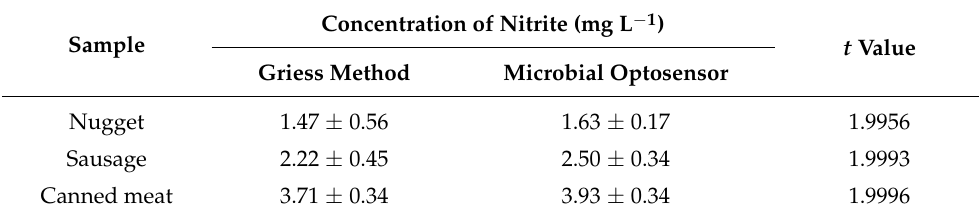
Table 2. Concentration of nitrite determined by both the UV-vis spectrophotometric Griess method and the reflectance microbial optosensor in processed meat products. The calculated t value is compared with the critical t value at 4 degrees of freedom and 95% confidence levels ( n =